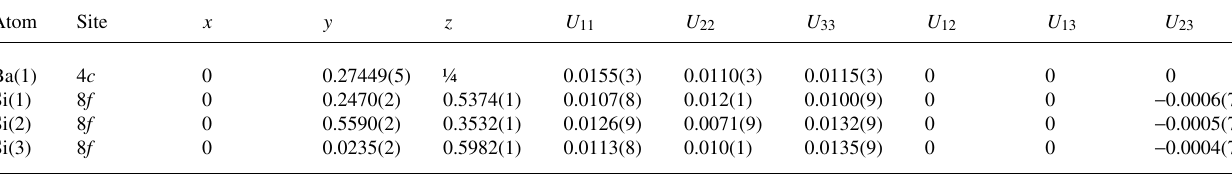
Table 2. Atomic coordinates and displacement parameters (in Å 2 )